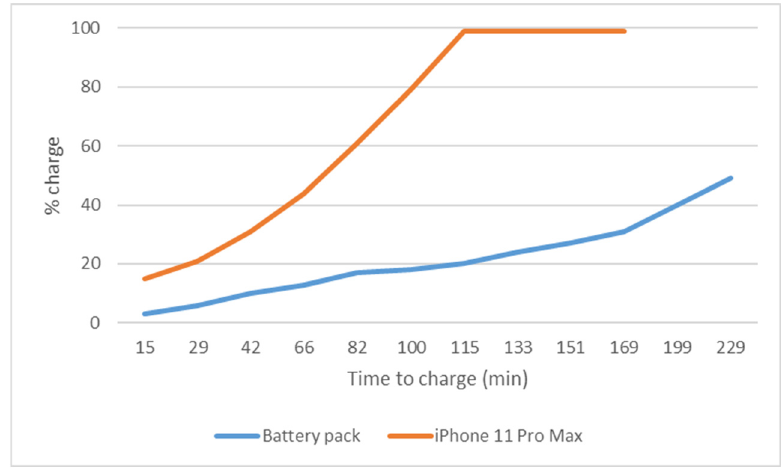
Figure 14. Percentage of charge as a function of time for the battery pack and the iPhone 11 Pro